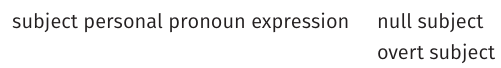
Table 5: Dependent linguistic